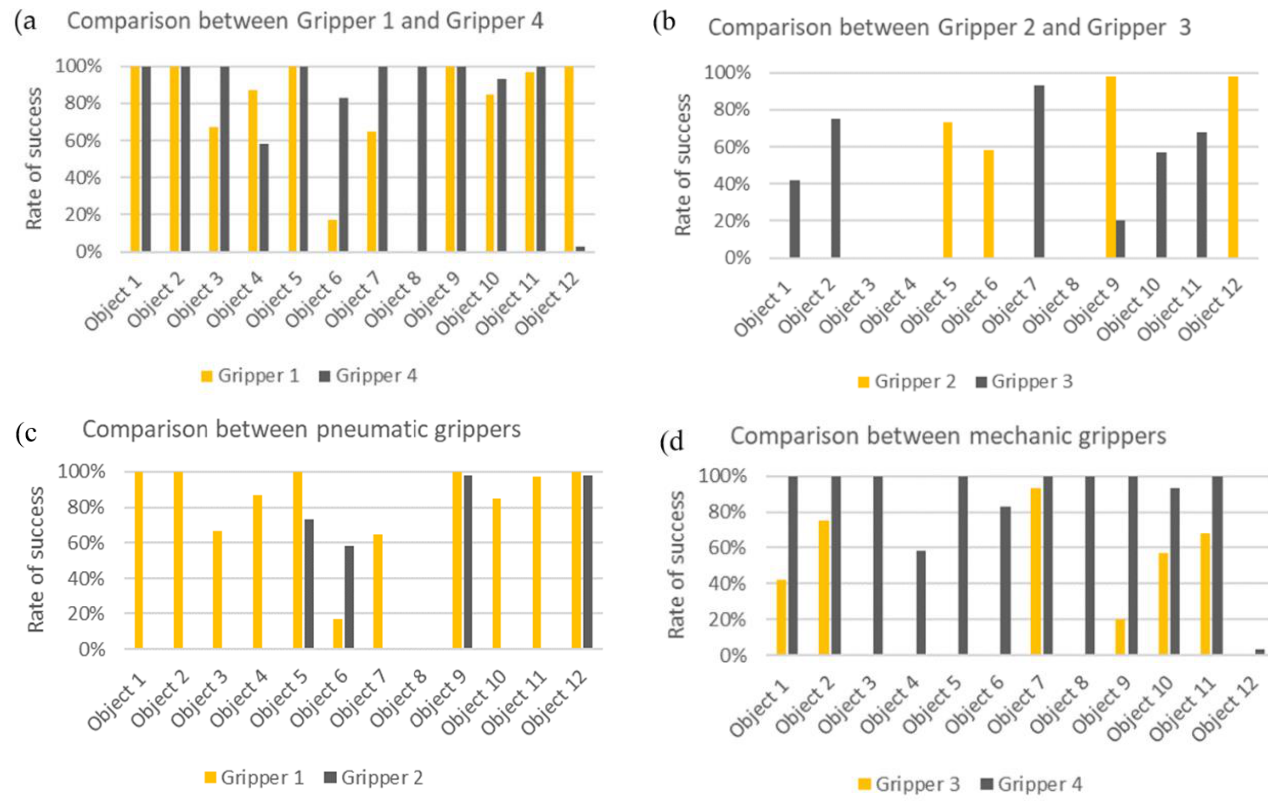
Figure 12. Graphic comparison between ( a ) Gripper 1 and Gripper 4. As can be seen from the graph, the two grippers generally have similar performances. ( b ) Gripper 2 and Gripper 3. These are the two grippers with the worst performances, and each one proved to be suitable only for a specific type of object. ( c ) Graphic comparison between Gripper 1 and Gripper 2 (the two pneumatic grippers). As can be seen from the graph, Gripper 1 works significantly better than Gripper 2. ( d ) Graphic comparison between Gripper 3 and Gripper 4 (the two mechanic grippers). As can be seen from the graph, Gripper 3 works significantly better than Gripper 4.